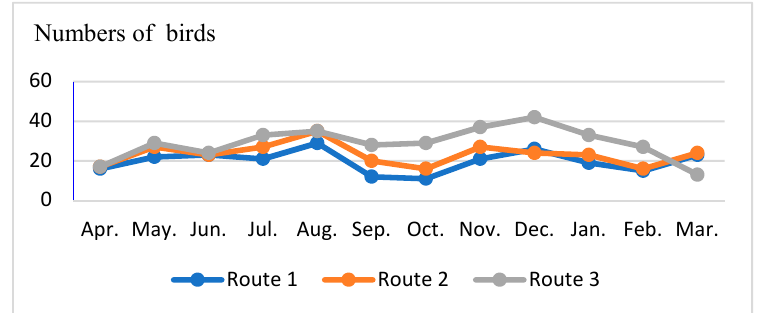
Figure 1 . Bird species found in 3 boat touring routes, in Tha-kha Sub-district, Samut Songkram Province.